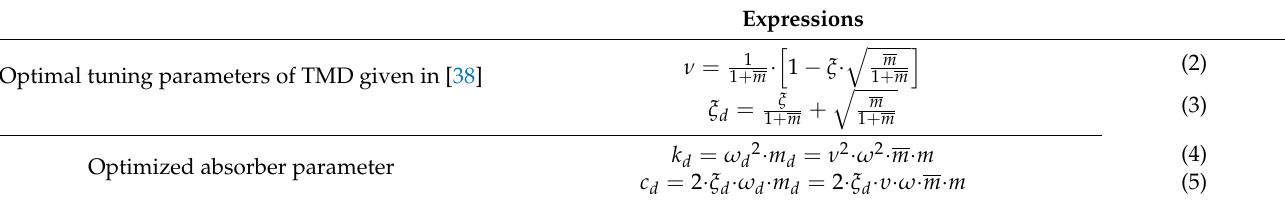
Table 2. TMD optimized parameters expressions.